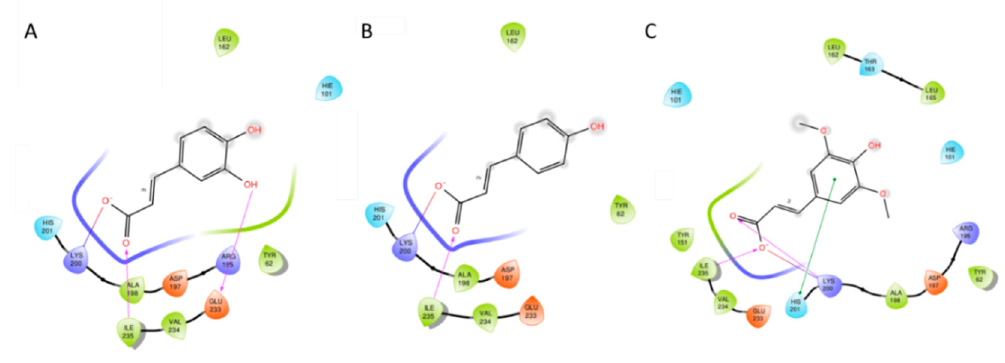
Figure 5. Binding mode of caffeic acid ( A ; 4 Gscore = − 4.02 kcal/mol), p ‐ coumaric acid ( B ; 6 Gscore = − 3.56 kcal/mol), and sinapic acid ( C ; 7 Gscore = − 3.89 kcal/mol), to human pancreatic α‐ amylase. Salt bridge interaction is depicted with a continuous blue/red faded line. Hydrogen bonds are shown with magenta arrows. ‐ Stacking interaction is plotted with a green capped line. Polar and hydrophobic contacts between ligand and enzyme residues are displayed with blue and green faded tick lines, respectively.